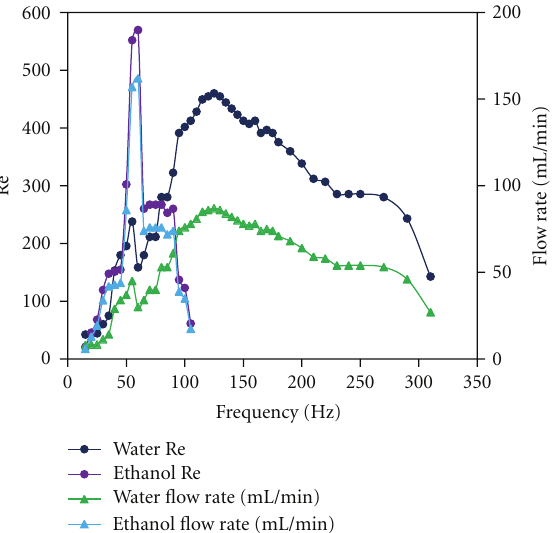
Figure 6: Measured flow rate under di ff erent frequency with di ff erent working fluids. (Case